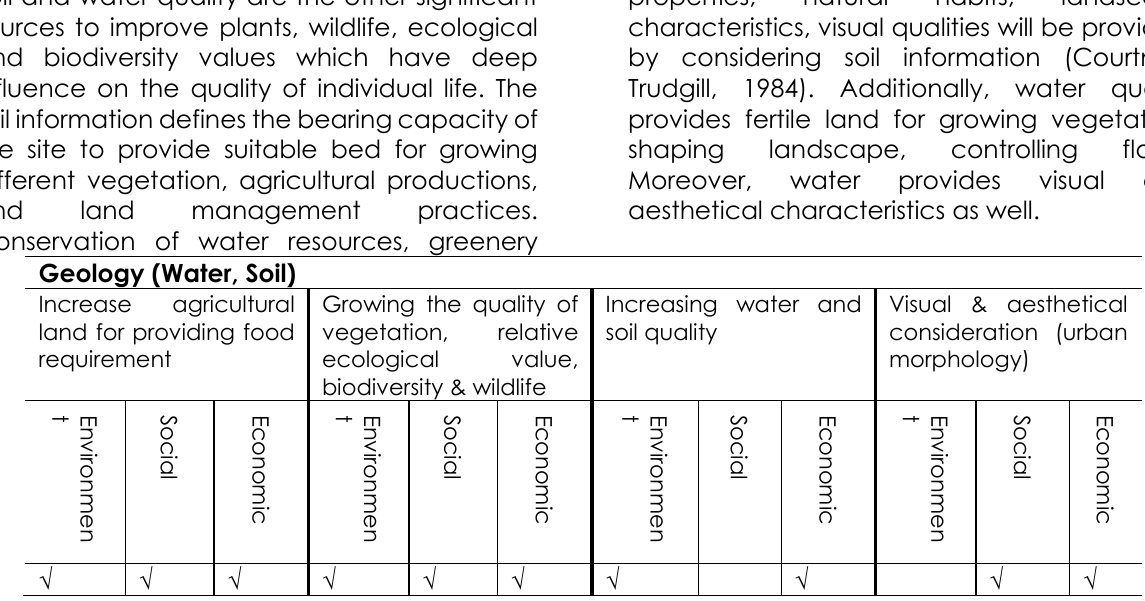
√ √ √ √ √ √ √ √ √ √ Table 5. Integration between Water and Soil Quality and Dimension of